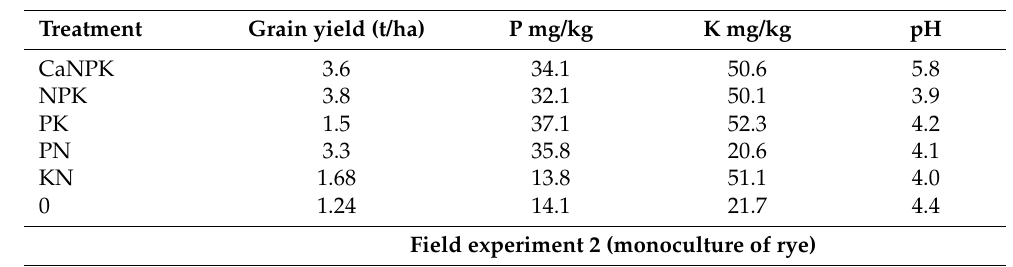
Table 1. Mean grain yield and content of available phosphorus, potassium (based on Egnera-Riehm method) and soil pH (in 1 M KCl solution) for recent 20 years. Field Experiment 1 (Crop Rotation without Legumes and Only Mineral